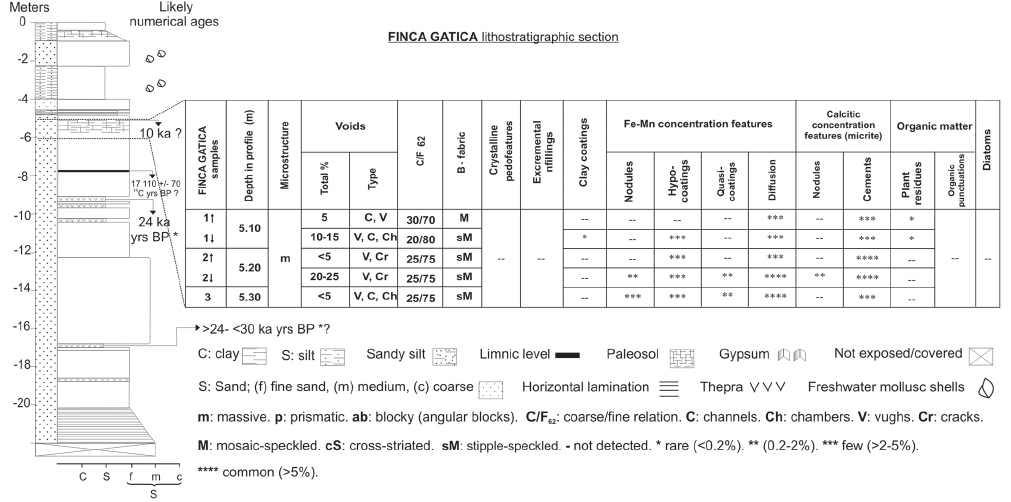
Fig. 6. Alluvial sequence field log at Finca Gatica study site (Arroyo La Estacada) and micromorphology of the ca. 10ka paleosol. A field log in Puente Roto study site (Arroyo Anchayuyo) is also schematized.